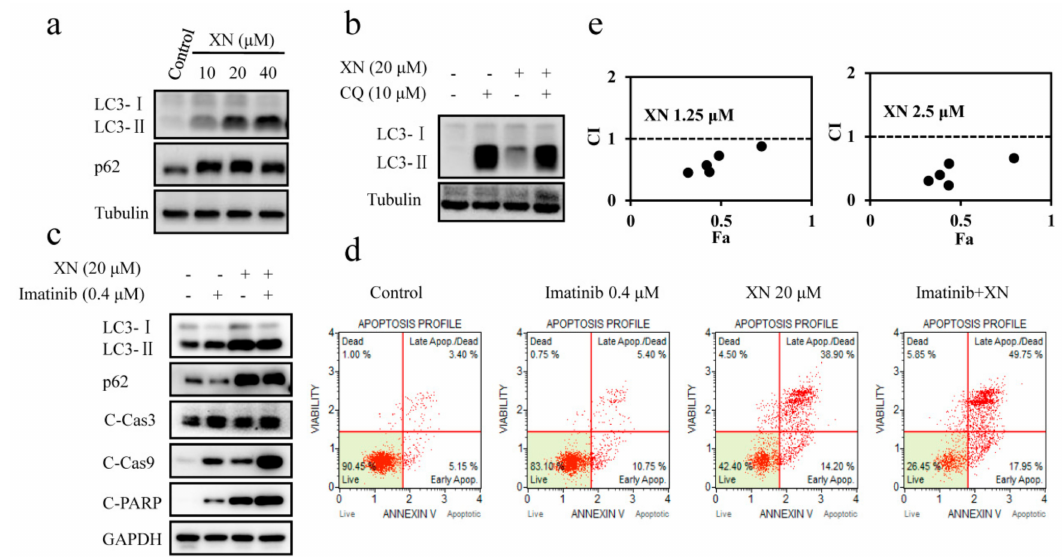
Figure 4. XN inhibits autophagosome maturation. ( a ) XN treatment alters autophagy-related proteins. K562 cells were treated with XN (0-40 µ M) for 24 h. Cell lysates were immunoblotted with indicated antibodies. Tubulin was immunoblotted as a loading control. ( b ) XN inhibits autophagy at its late stage. K562 cells were treated with 10 µ M chloroquine (CQ) and / or 20 µ M XN for 24 h, and the expression of LC3 was determined by Western blotting. ( c ) XN alleviates imatinib mediated autophagy and increases (0.4 µ M) for 24 h, the expression of LC3, p62, cleaved caspase-3 (C-Cas3), cleaved caspase9